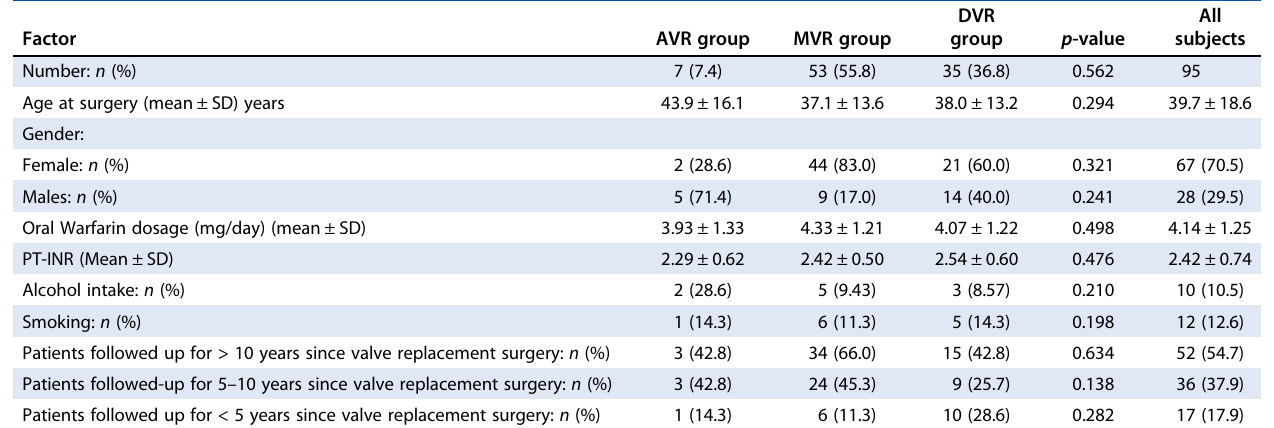
Table 1: Demographic and relevant clinical characteristics of study participants